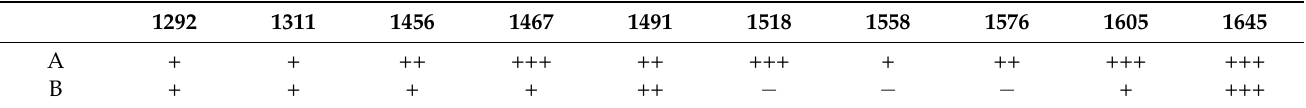
Table 3. Autopeak intensity in the two-dimensional correlation infrared (2DIR) spectra of pterocarpus